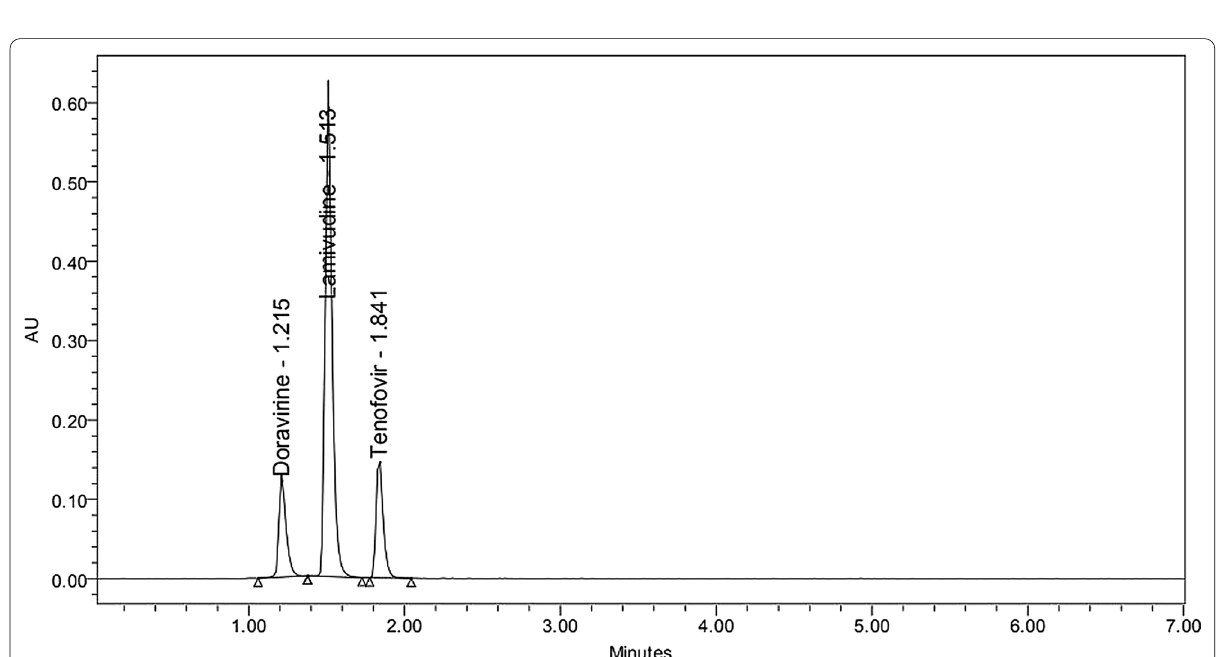
Fig. 6 Chromatogram of the acid degradation